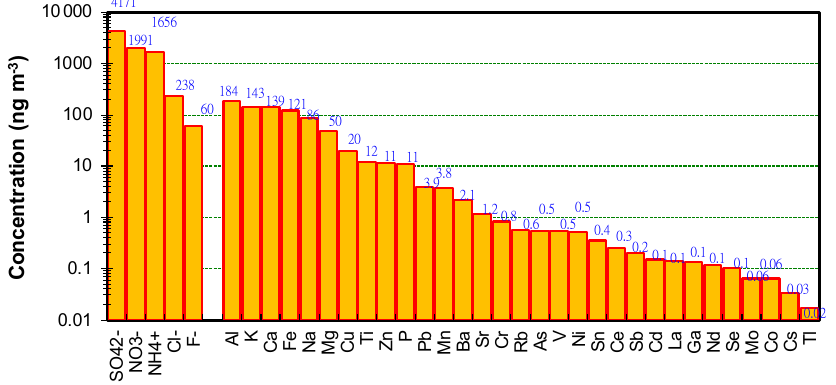
Figure 3. Average concentrations (ngm − 3 ) of chemical compositions in TSP samples collected at Mount Hehuan site from September 2011 to September